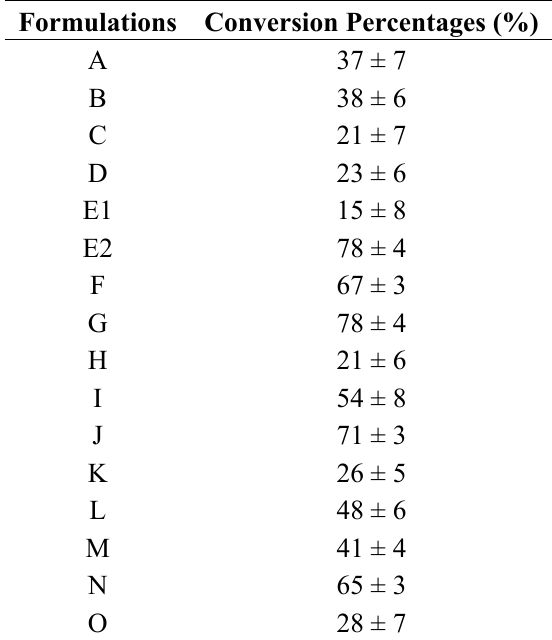
Table 4. Conversion percentages obtained for the UV high-solids formulations.